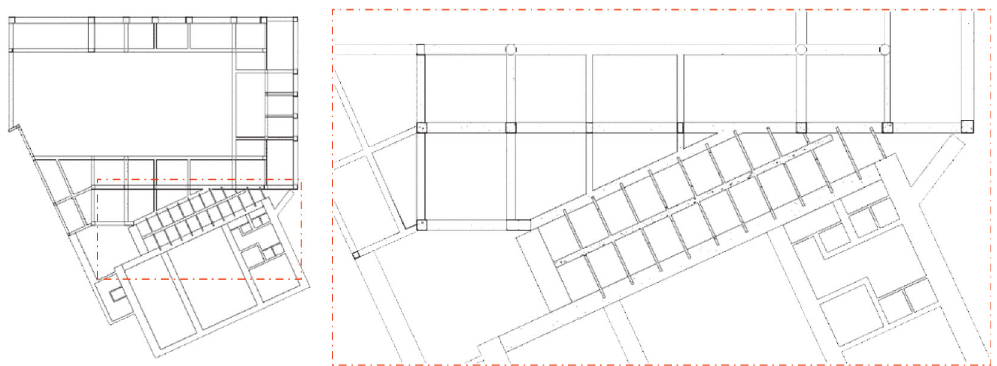
Figure 7: Detail of the connecting floor: identification (a) and zoom (b).